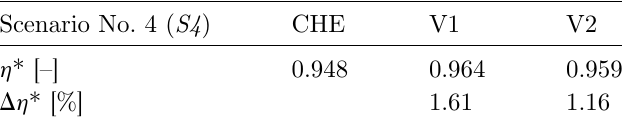
Table 5. The weighted hydraulic ef fi ciency for each solution and the ef fi ciency gain with respect to the existing one in scenario No. 4 ( S4